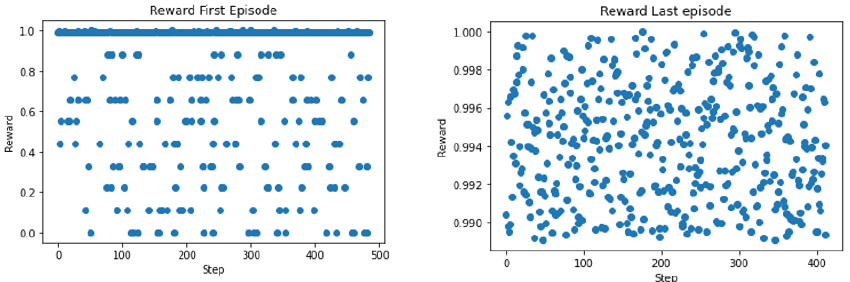
15 of 23 Figure 15. Exploration rate plotted over episodes. 5. Simulation The introduced RL algorithm was trained in the Python environment before transfer- ring the learning to the Linden network. The algorithm was trained over 1000 episodes which results in about 500,000 steps. The normalized training rewards for the first and last episodes are shown in Figure 16. The RL algorithm was trained for m = 4 and 10 SAV stops. Then, it was extended to encompass the case of six stops, and two- and four-size fleets. The SAV dispatcher can be regarded as a function f that maps current requests at time req t to next deployment destinations for each vehicle i , b i , next . The variable req t consists of a three- tuple containing the time the request was placed, T reqt , the pick-up spot, b up , and the drop- off spot b off . Thus, under policy π